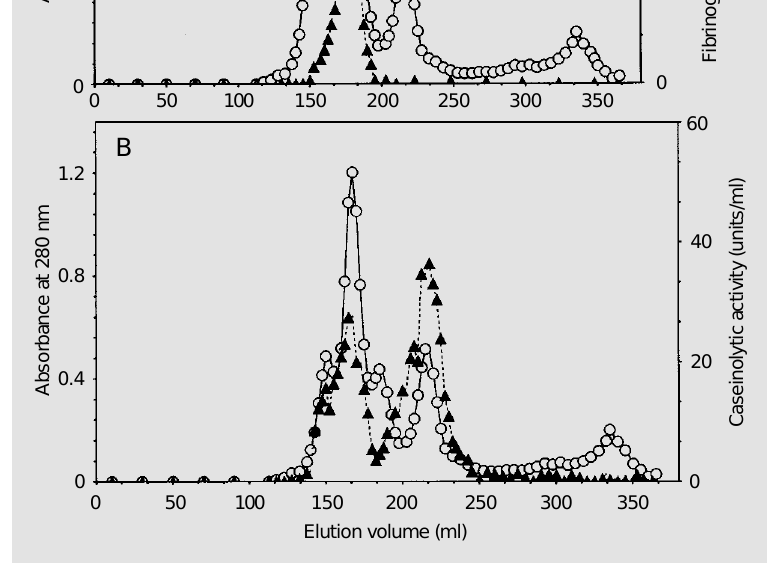
Figure 1 - Size exclusion chromatography of crude B. atrox venom (50 mg) on a Sephacryl S-100-HR column (2.5 x 67.0 cm). The venom was solubilized in 25 mM Tris-HCl, pH 7.5, plus 150 mM NaCl. Protein concentra- tion was monitored at 280 nm (circles). A , Thrombin- like activity is indicated by triangles. B , Caseinolytic activity is indicated by triangles.